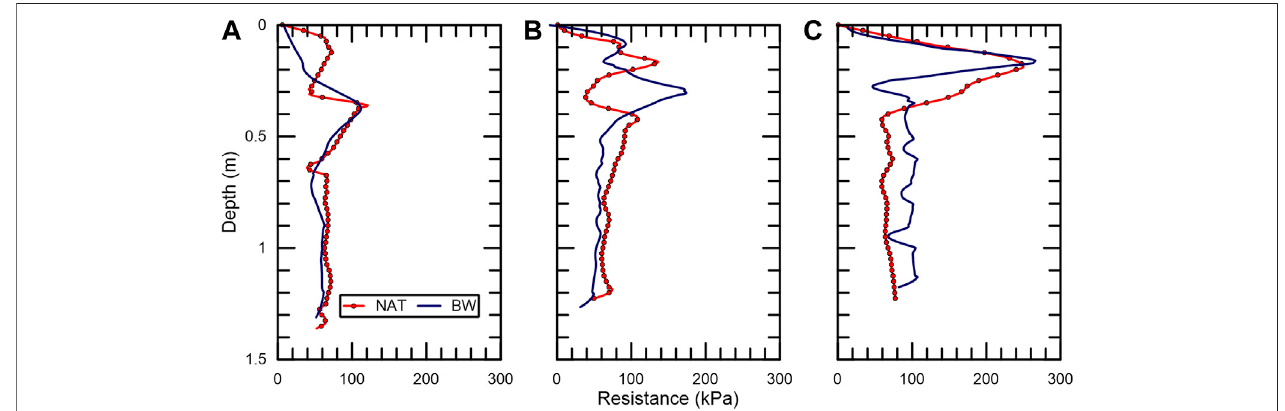
FIGURE14| Modi fi edcone-penetrometerresistancevalueswithdepthfor (A) sitesclosesttotheshoreline, (B) thelocationsatthemidpointbetweenshorelineand furthest inland site, and (C) furthest inland